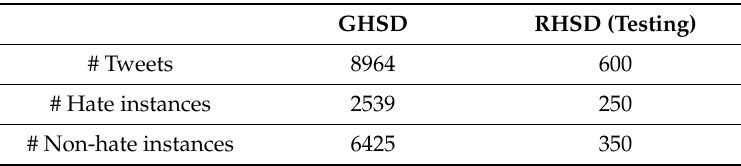
Table 2. Statistics of datasets used in the